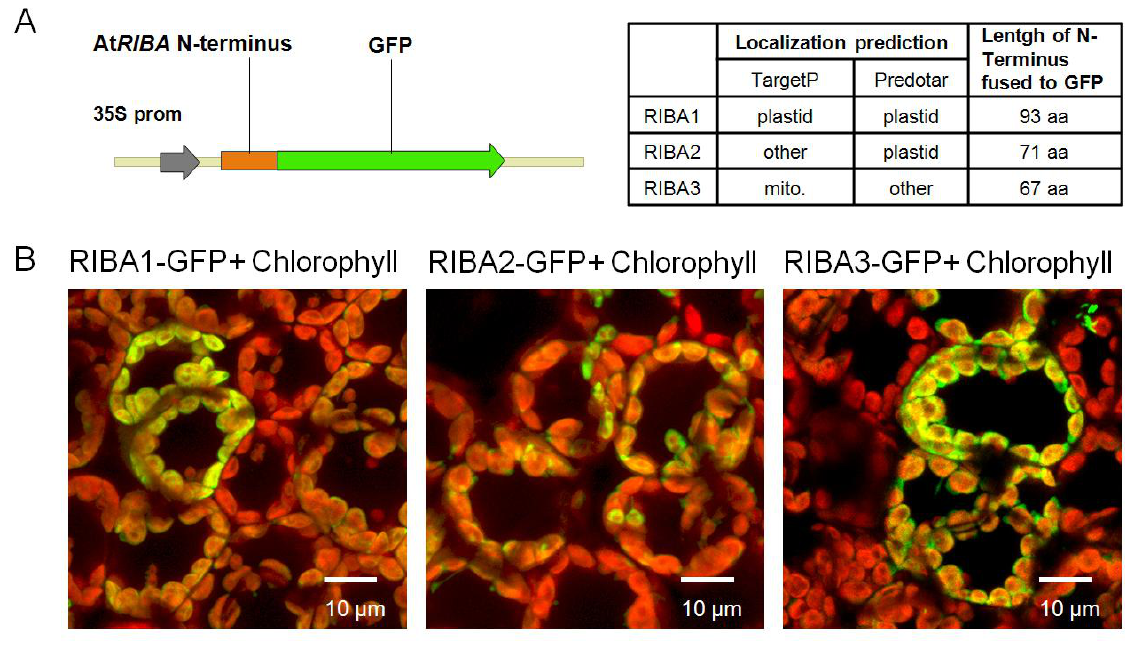
Figure 4. Green fluorescent protein (GFP) localization experiments. ( A ) The amino terminal sequences comprising the putative transit peptides were translationally fused to the N -terminus of GFP. Targeting properties were predicted using TargetP and